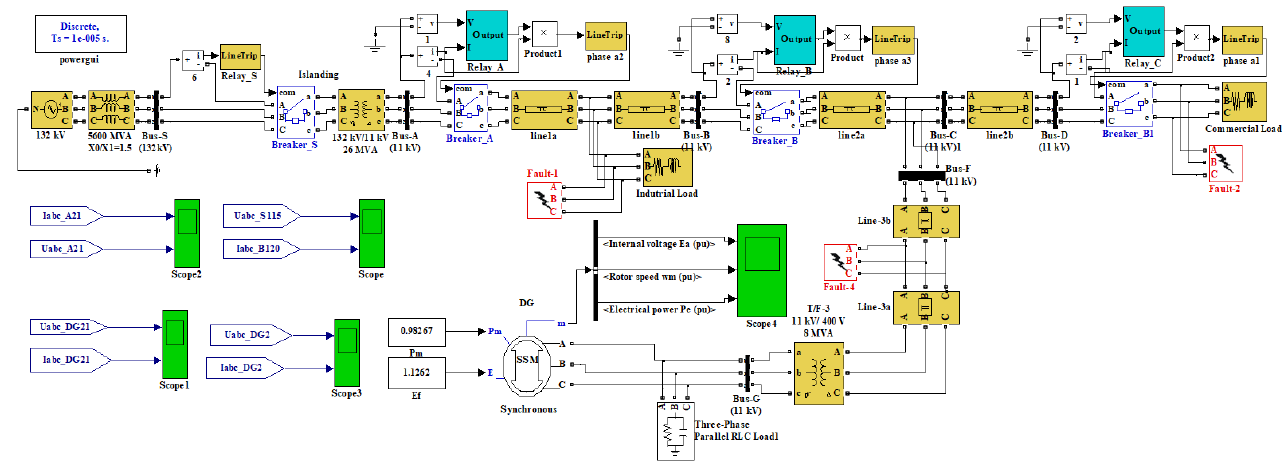
Figure 6. Simulink model of test system for investigating voltage sag and protection coordination. A synchronous DG is integrated into system and all the measurement are taken at the point of common coupling. An auxiliary load also is connected in parallel to DG system to avoid its unloaded operation due to the fact that it may overshoot and damage its armature.